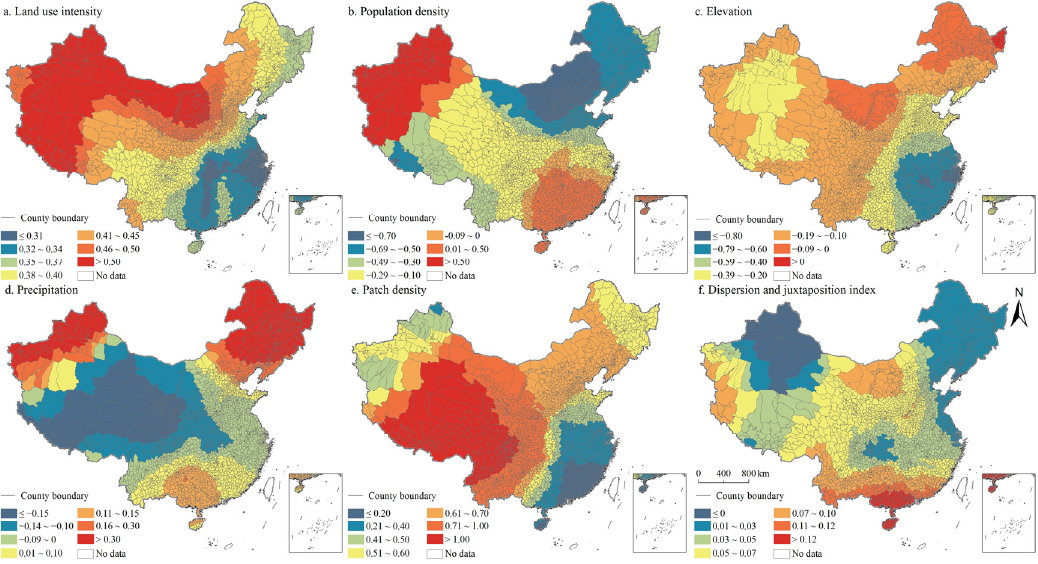
Figure 14. Spatial distributions of the regression coefficients of GWR models in China in 2000.